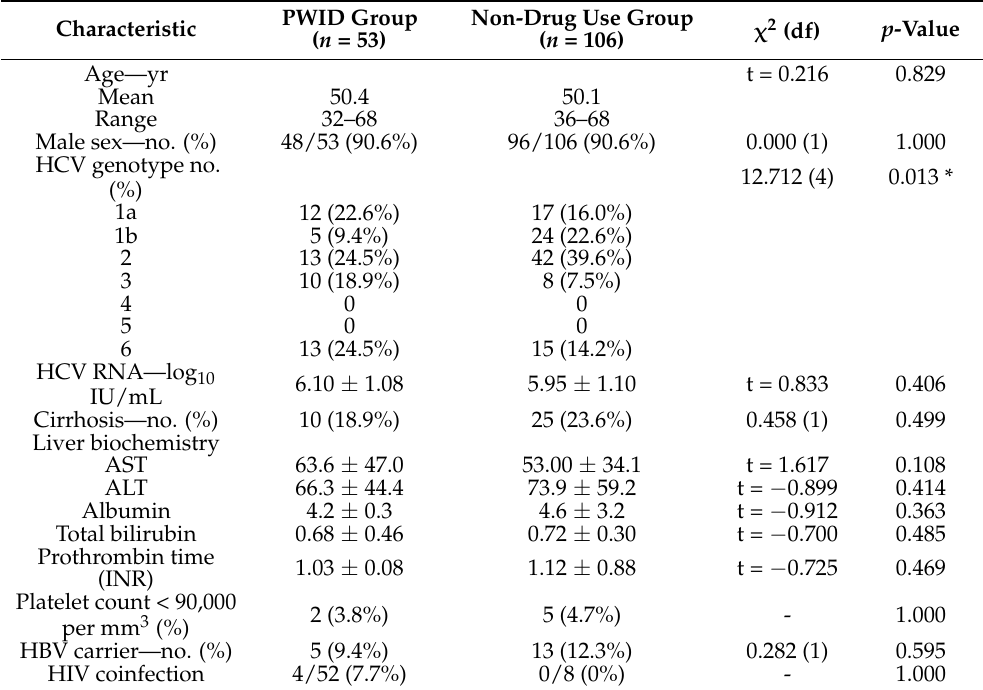
Table 1. Demographic data of the PWID and non-drug use groups. Characteristic